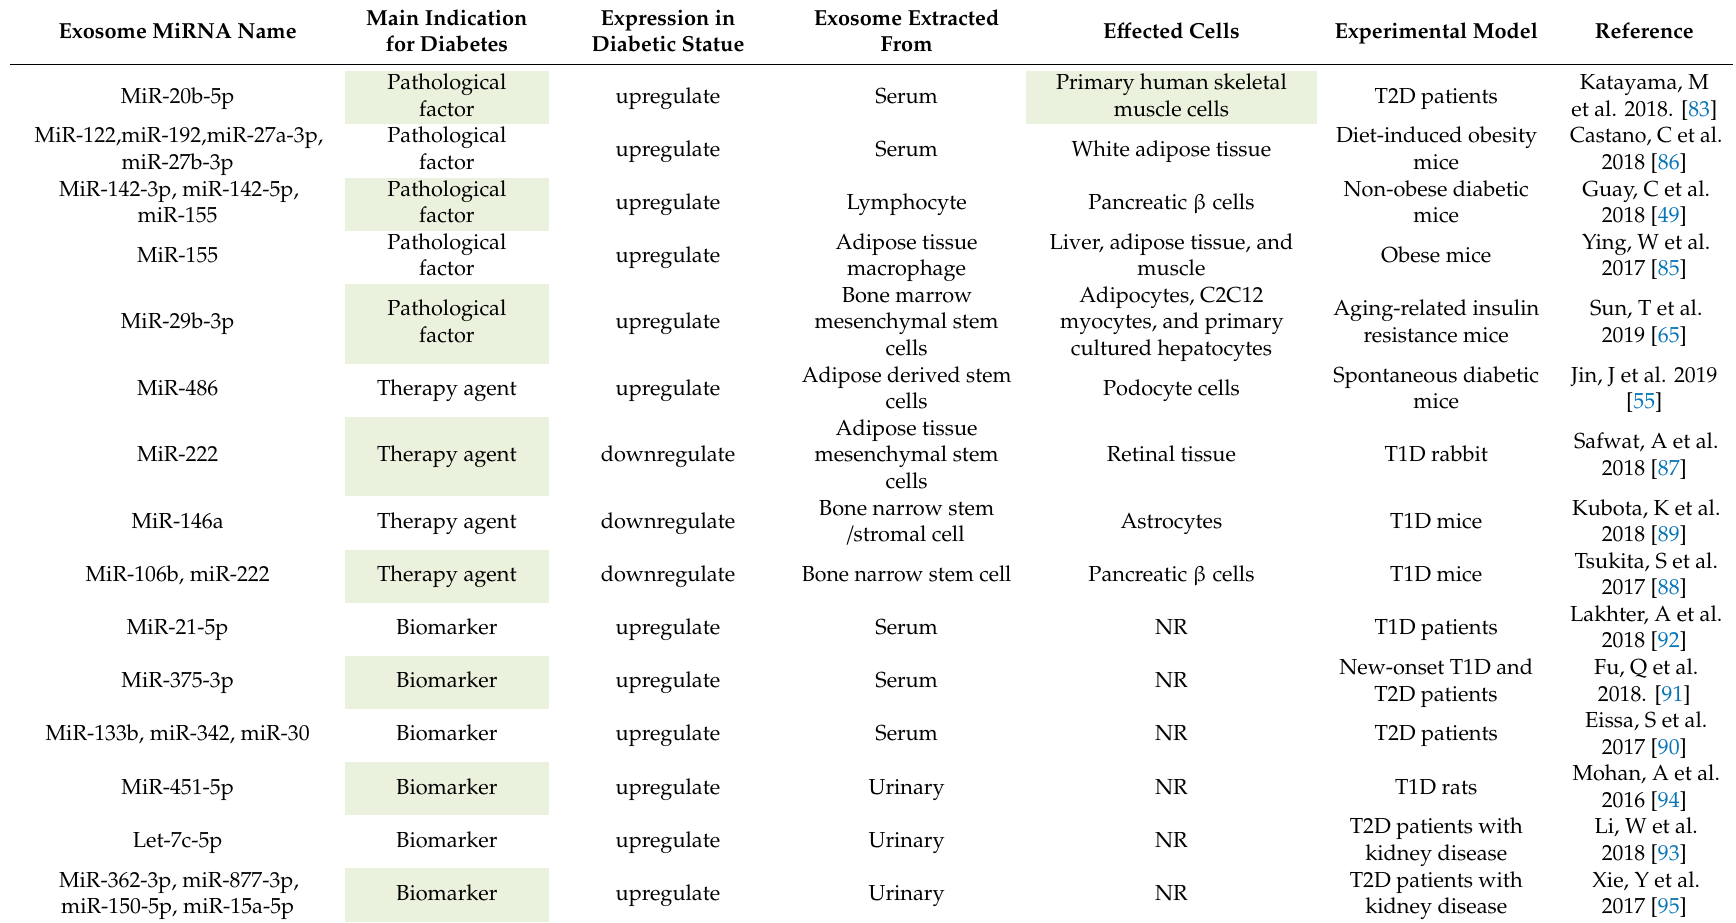
Table 1. Current studies of exosomal microRNAs (miRNA) in